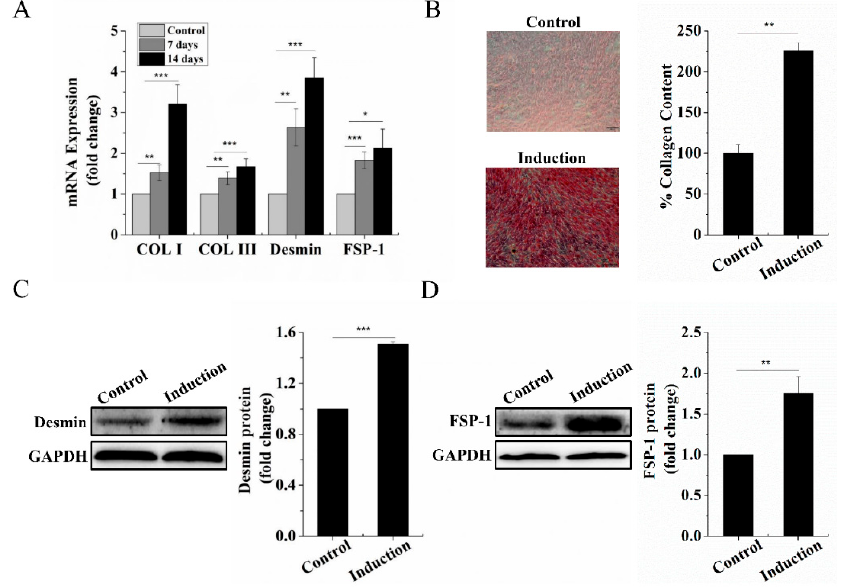
Figure 1. Fibroblastic differentiation of BMSCs upon stimulation with CTGF and ascorbic acid. ( A ) mRNA expression of Col I Col III, Desmin, and FSP-1 after 7 and 14 days of induction by RT-qPCR detection. ( B ) Sirius red staining for Col I and Col III deposition evaluation in BMSCs and quantifi- cation data of Sirius red staining after 7 days of induction (scale bar, 100 µm). ( C ) Western blot detection of the Desmin protein level after 7 days of induction. ( D ) Western blot detection of the FSP-1 protein level after 7 days of induction. Data are presented as mean with SD; BMSCs: bone marrow-derived mesenchymal stem cells; CTGF: connective tissue growth factor; Col I: collagen I; Col III: collagen III; FSP-1: fibroblast-specific protein-1; GAPDH: glyceraldehyde-3-phosphate de- hydrogenase. n = 3, * p < 0.05; ** p < 0.01; *** p <0.001. 2.2. SMG Inhibited Dermal Fibroblastic Differentiation of BMSCs The 2D-clinostat device (Figure 2A) was utilized to simulate microgravity in this study. First, we assayed the effect of SMG on dermal fibroblastic differentiation of BMSCs by testing the mRNA expression levels of Col I, Col III, Desmin, and FSP-1. Figure 3A shows that the mRNA expression of the markers above strikingly decreased under SMG conditions compared to that of normal gravity (NG). Similarly, we found that the deposi- tion intensity of Col I, Col III and quantification data of Sirius red staining (Figure 3B) and protein level of Desmin, FSP-1 (Figure 3C,D) were significantly decreased under SMG conditions compared with that of NG. These results indicated that SMG suppressed the differentiation of BMSCs into dermal fibroblasts.